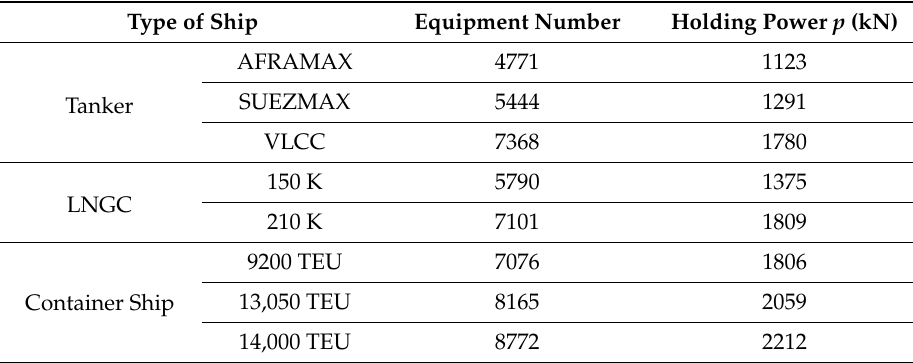
Table 2. Holding power of anchors ( K a ) and anchor chains ( K c ).